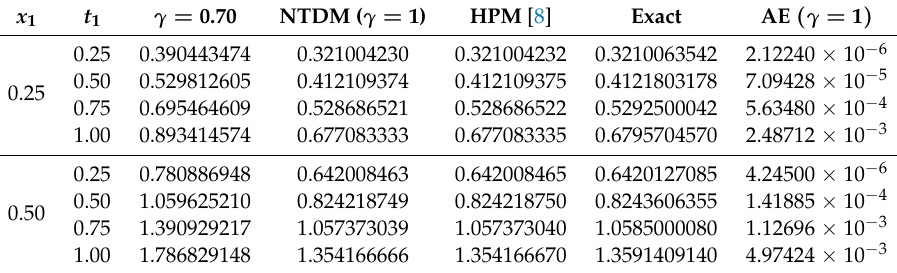
Table 1. Numerical results of Example 1 at γ = 0.70, 1 and Absolute